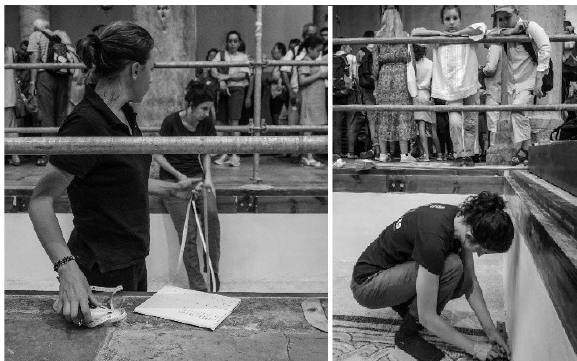
Figure 9. The flows of users inside the Basilica have strongly influenced the survey campaign activities numbered squares for mosaic A were more than 700, allowing us to orient the grid squares in relation to the border.